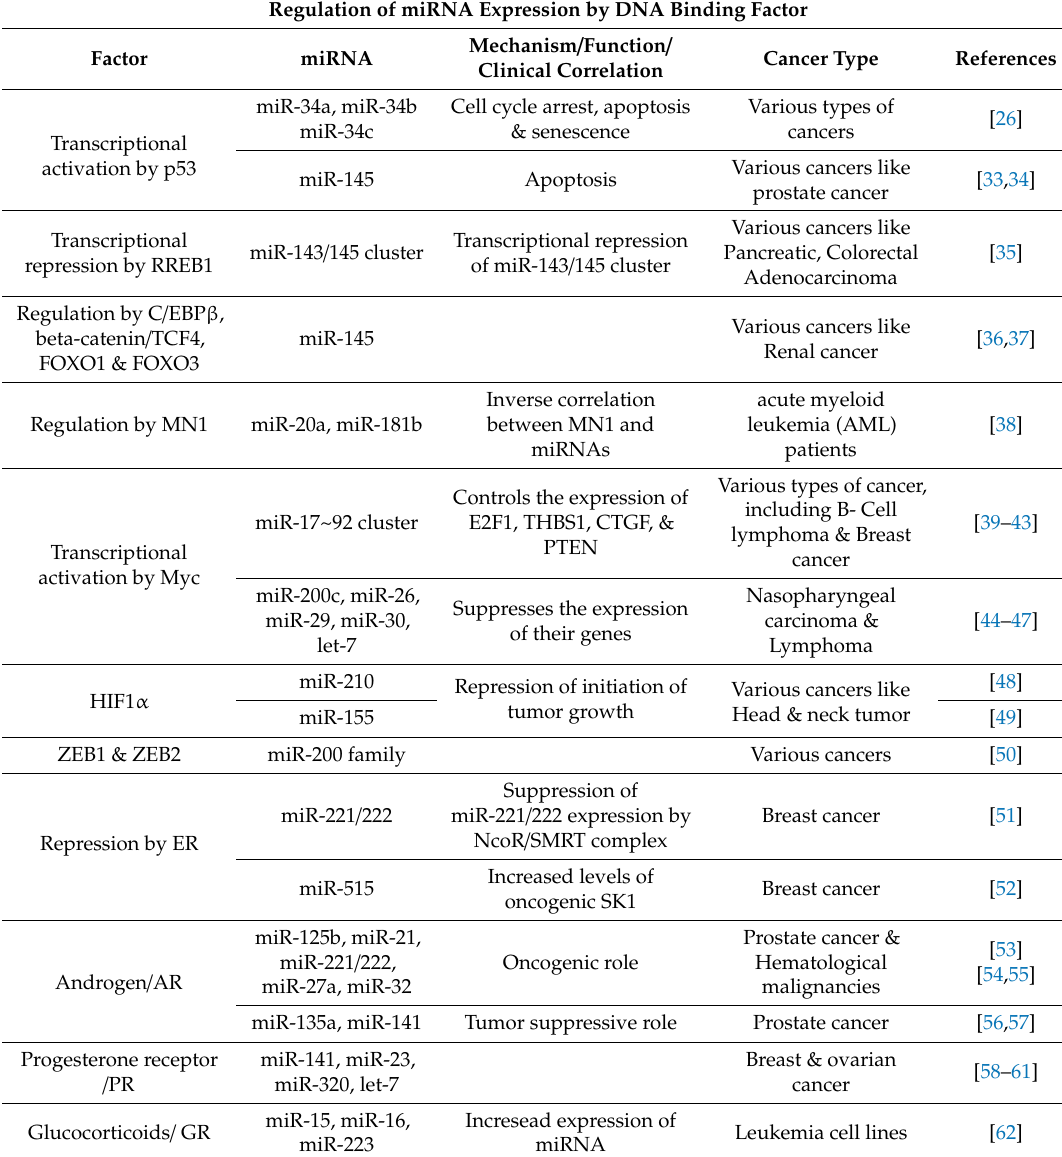
Table 1. Dysregulation of miRNA transcription in